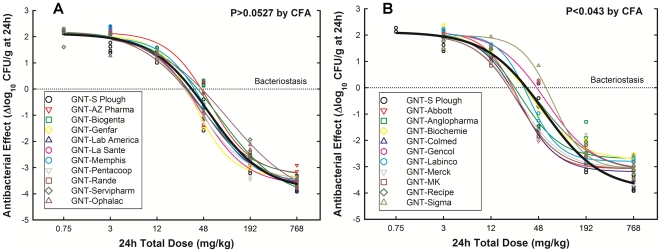
In vivo pharmacodynamics.Panels illustrate the dose-response curves derived from the neutropenic mouse thigh infection model of 19 generic products and the reference powder with (A) or without (B) therapeutic equivalence respect to the innovator.